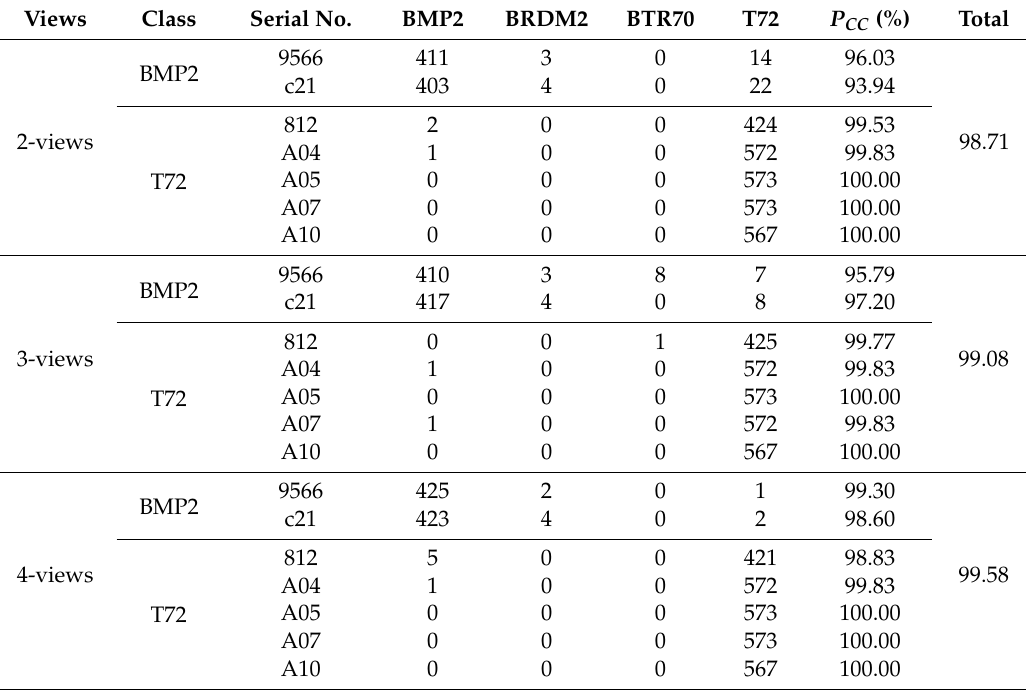
Table 11. Confusion matrix of the MS-CNN under EOC-2 (configuration